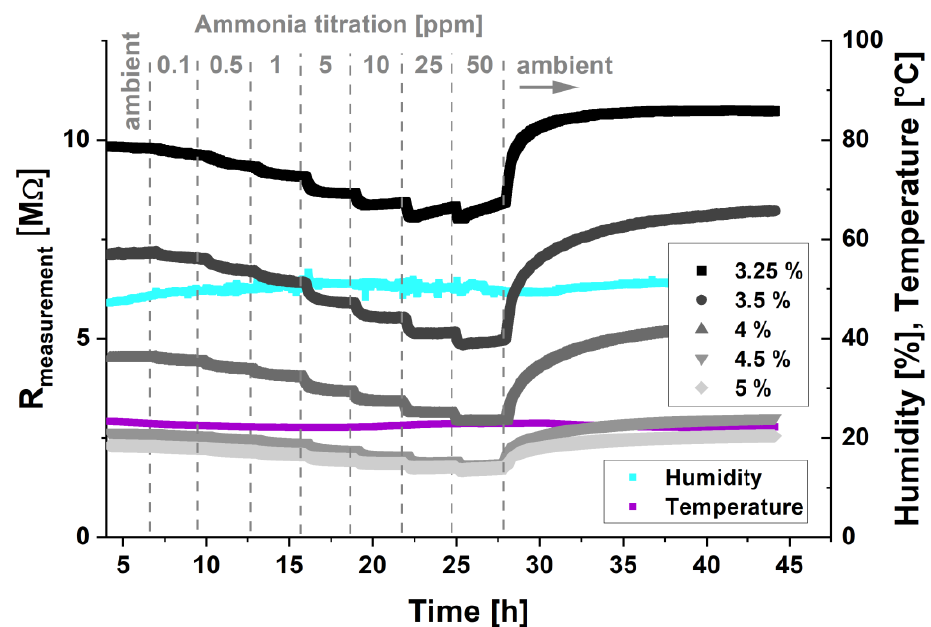
Figure 3. Liquid calibration unit measurements of polyaniline sensors doped with different F4TCNQ concentrations—3.25% (black curve), 3.5% (red curve), 4% (blue curve), 4.5% (orange curve), and 5% (wt%) (green curve). Humidity (turquoise) and temperature (purple) were monitored during the whole duration of the experiments.